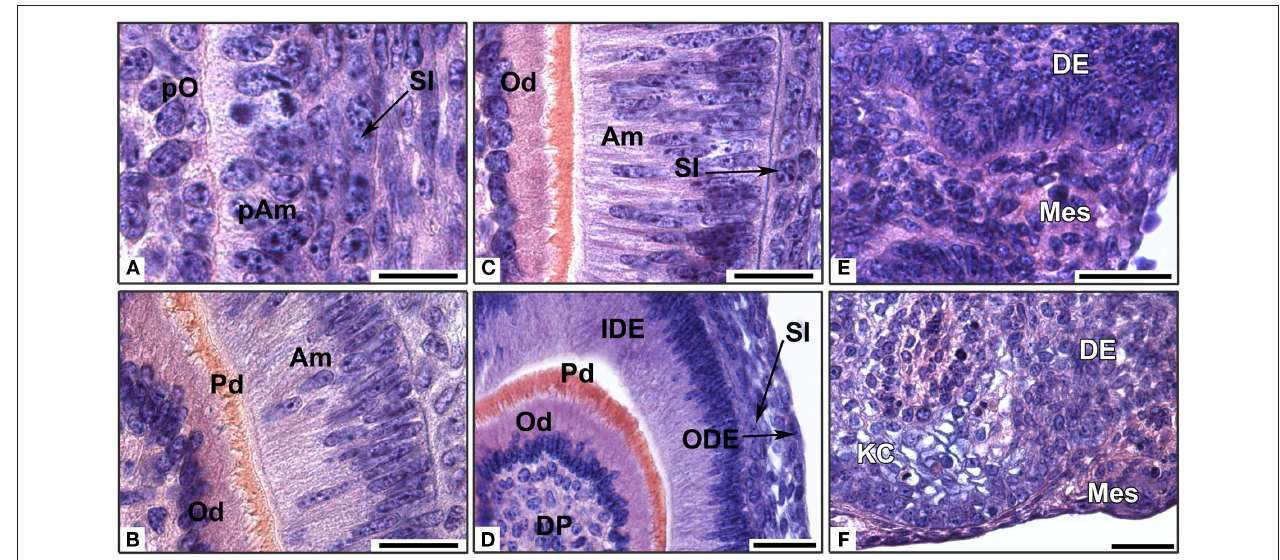
FiGuRe 3 | In vitro development of re-associations between an eD14 intact dental epithelium and dissociated dental mesenchymal cells from different embryonic stages. Dental epitheliums were re-associated with mesenchymal dental cells from embryonic days 14 (A,B) , 16 (C,D) , or 18 (e,F) . The re-associations were cultured for 2 days (e) , 6 days (A,C,D,F) ,